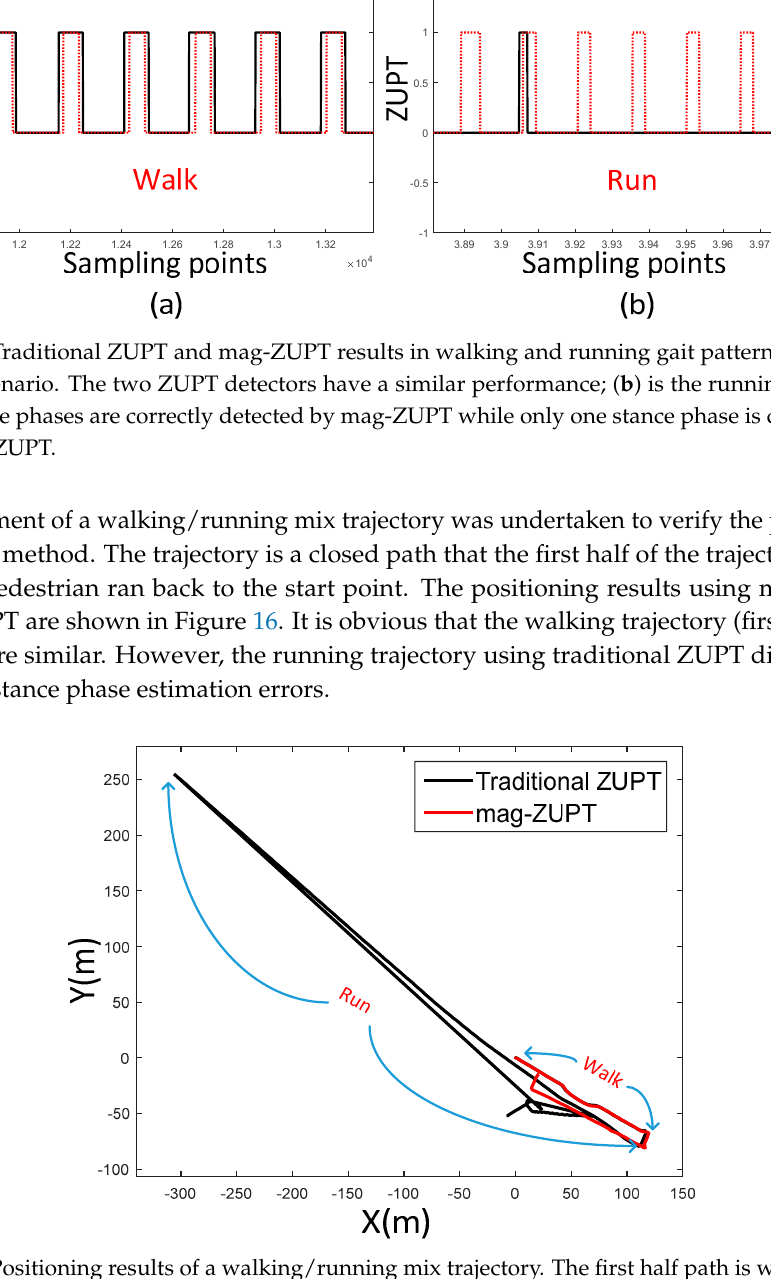
Figure 16. Positioning results of a walking/running mix trajectory. The first half path is walking and the second half path is running. Traditional ZUPT cannot detect stance phase correctly of running gait pattern, therefore the positioning result diverges rapidly.